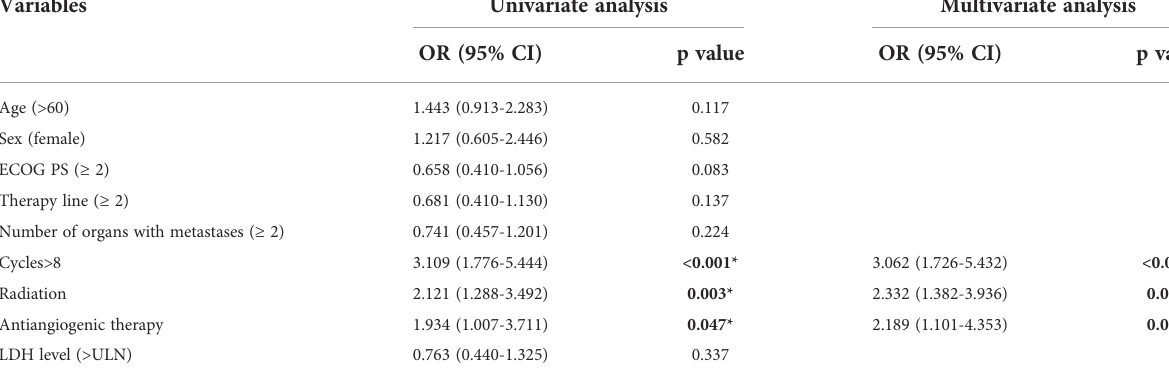
TABLE 5 Results of univariate and multivariate analyses showing factors affecting the